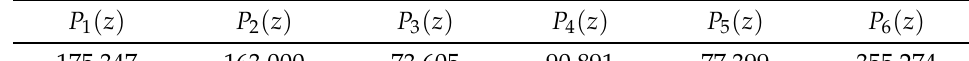
Table 2. Execution time (seconds) required by PS9 for each P i ( z ) , i = 1,2, . . . ,6.